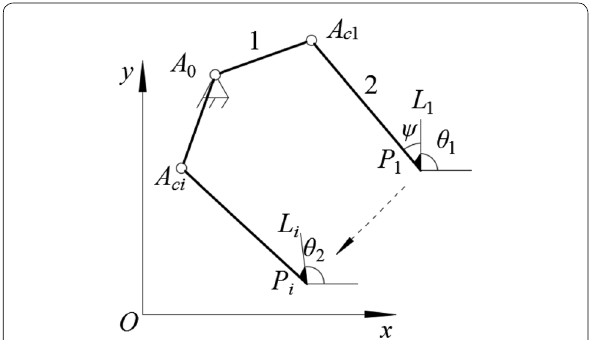
Figure 10 Motion analysis of the bar-group model. 1. Planetary carrier; 2. Seedling-clamping